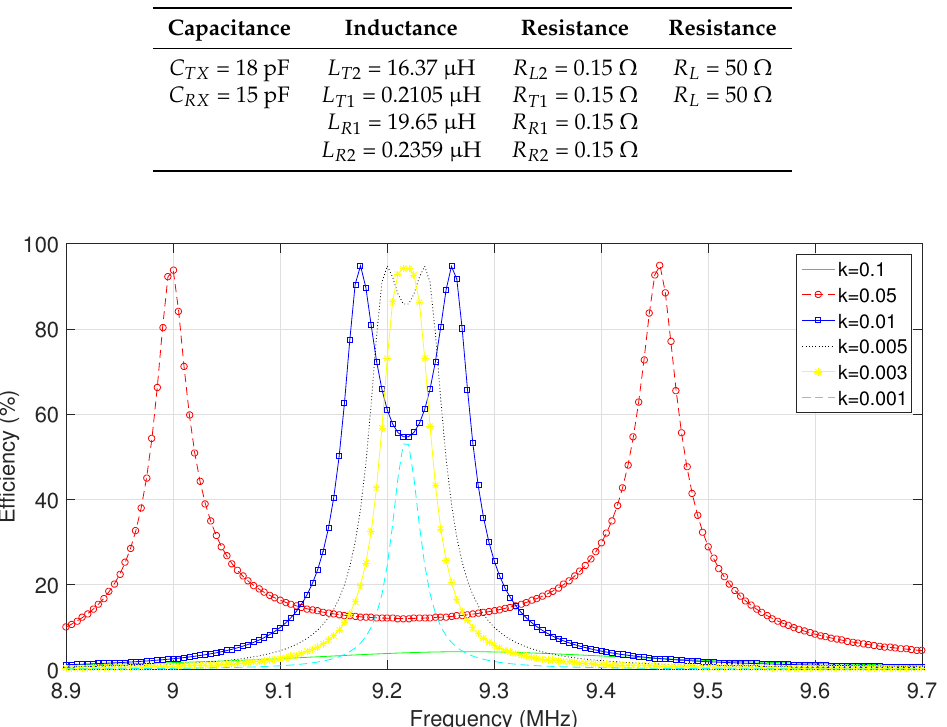
Figure 9. Calculated efficiency of the proposed system with low Q of the coils with two additional inductors. The coupling factor at which maximum efficiency is much smaller than that for the low Q design without additional